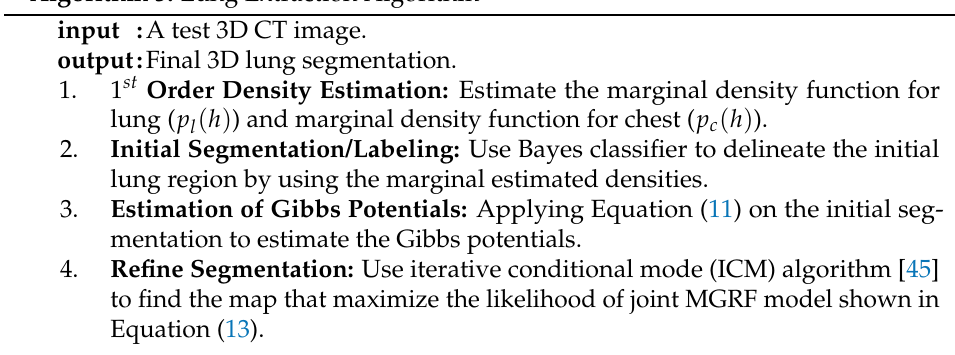
Algorithm 3: Lung Extraction